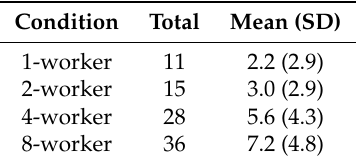
Table 9. Summary of discontinuities in the crowd generated